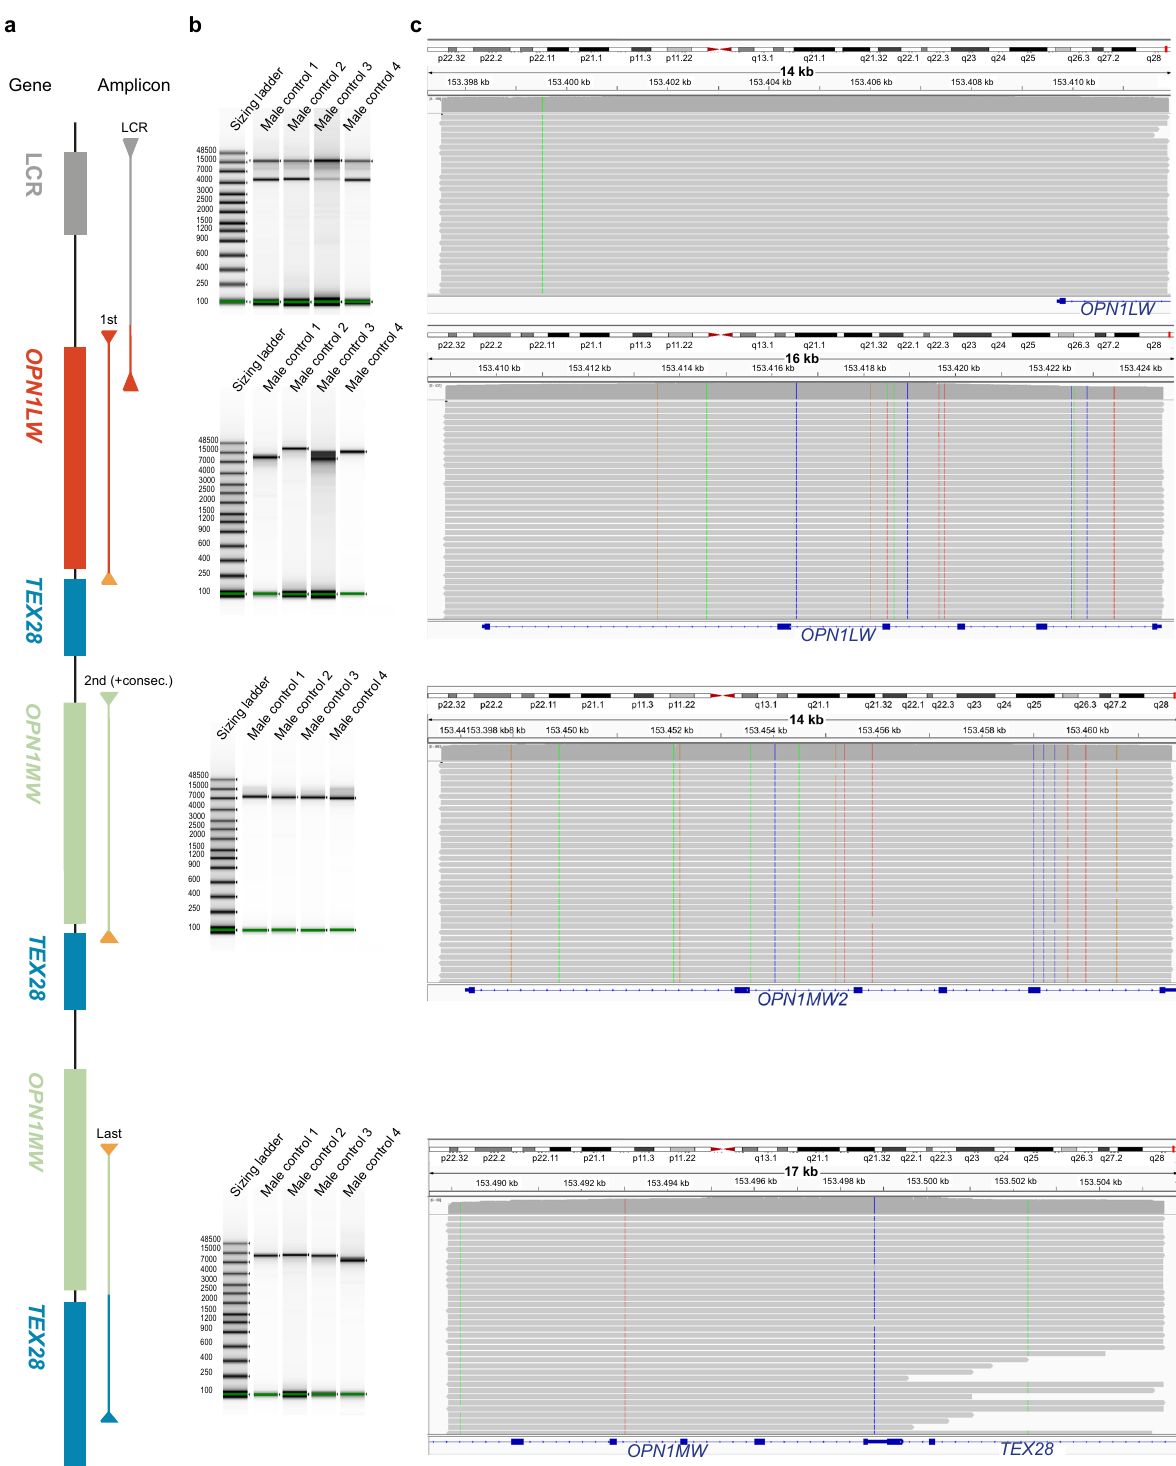
Fig. 2 Gel electrophoresis and sequencing data of all four amplicons. a Schematic overview of the OPN1LW/OPN1MW gene cluster. The location of the four amplicons designed for the OPN1LW/OPN1MW gene cluster are depicted as bars beginning and ending with an arrow. b Gel electrophoresis results of four male control samples for each of the four amplicons and a sizing ladder (in base pairs). For each amplicon PCR and sequencing was done in parallel for all samples. Moreover for each amplicon PCR products of all samples were run on a single DNA ScreenTape Analysis. c Long-read sequencing results of one of the previously mentioned control samples shown in IGV for each of the amplicons. On the top the chromosomal location is depicted and on the bottom the speci fi c gene(s) located at this region is/are